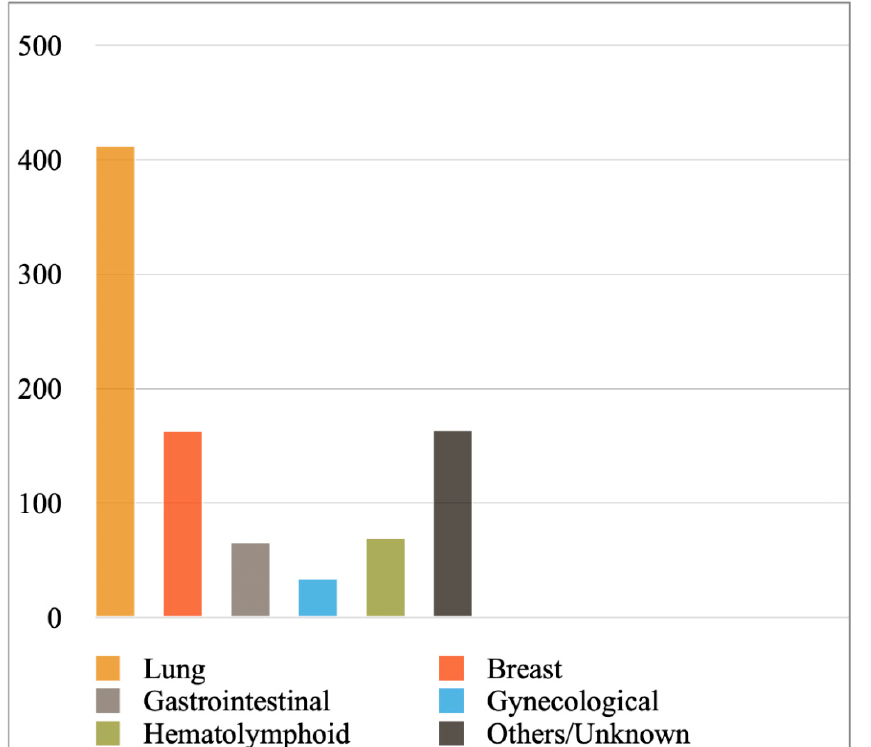
Figure 2. Most prevalent cancer primaries in malignant pericardial effusions. In the included studies, results were reported with cytology or a combination of cytology and biopsy.